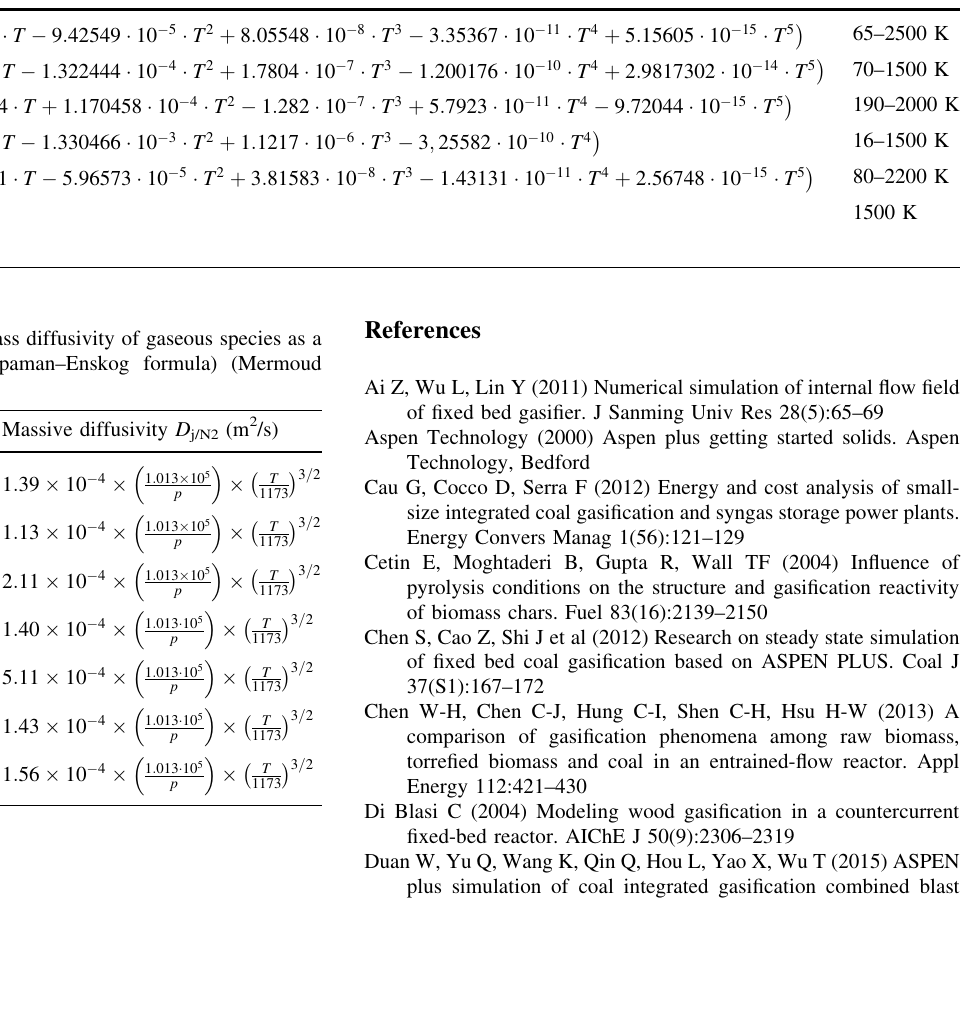
Table 14 Expression of the thermal conductivity of gaseous species and carbon as a function of temperature (Monteiro et al. 2018; Lu et al. 2018) Species Thermal conductivity (mW m - 1 K - 1 )